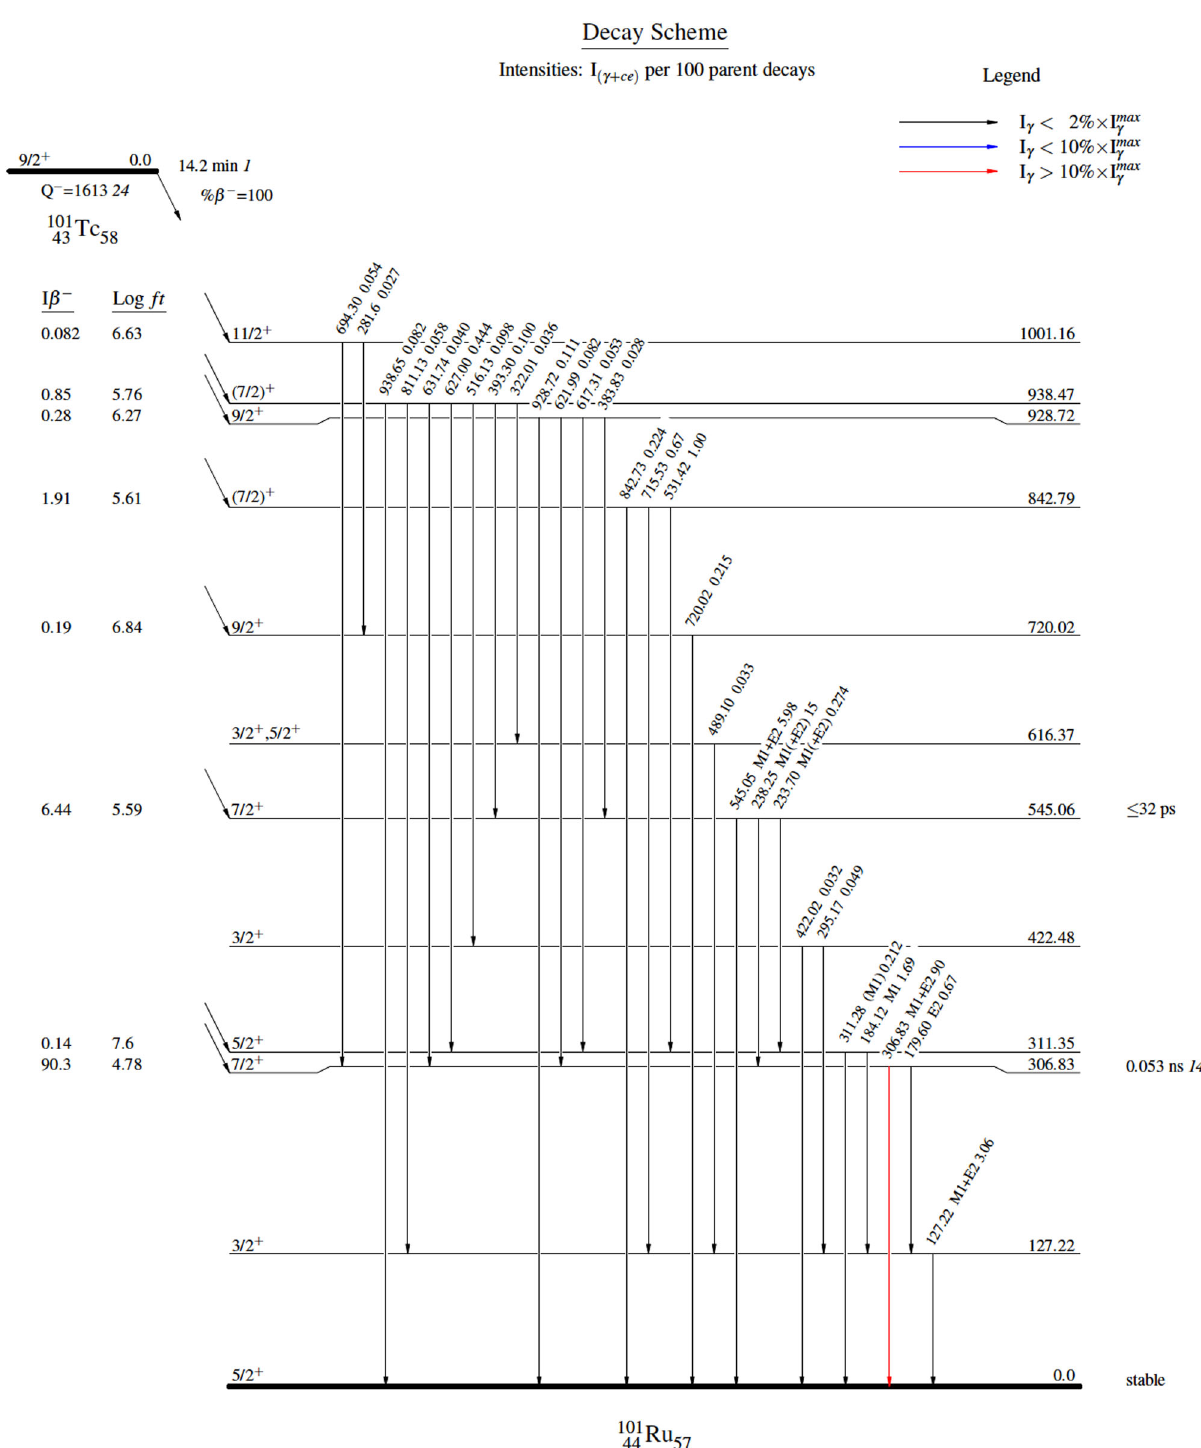
Fig. 1 Decay scheme of 101 Tc to 101 Ru. Image generated via Evaluated Nuclear Structure Data File (ENDSF) database 33